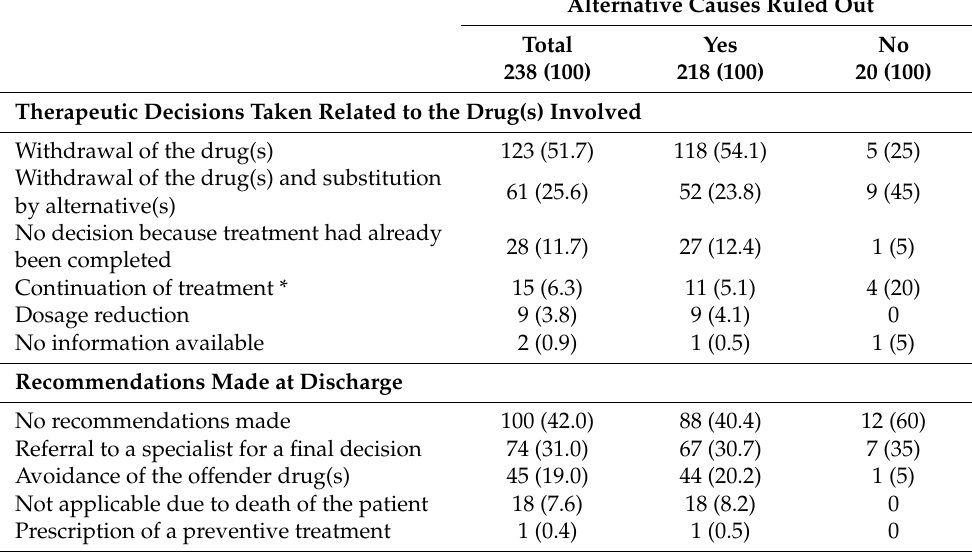
Table 3. Therapeutic decisions taken and recommendations made at discharge when ADRs